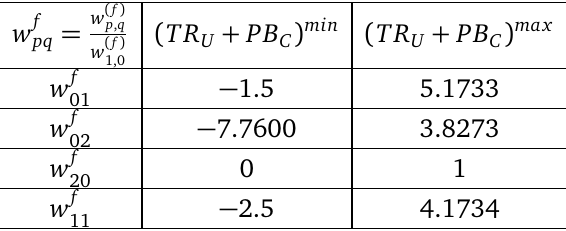
up to n = 2 in the U